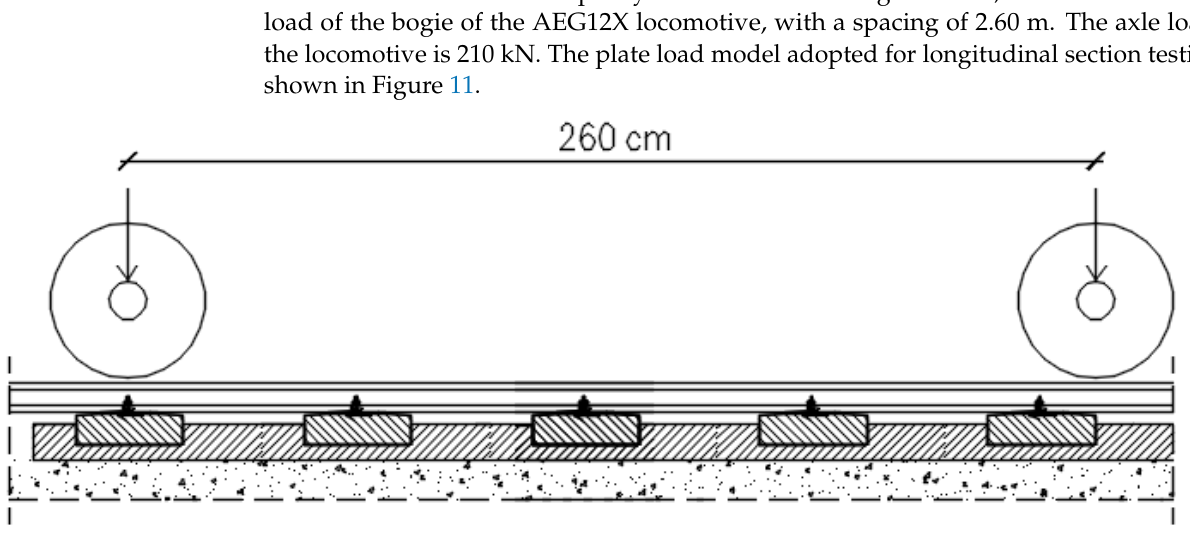
Figure 11. Scheme of loading the railway surface with a locomotive.